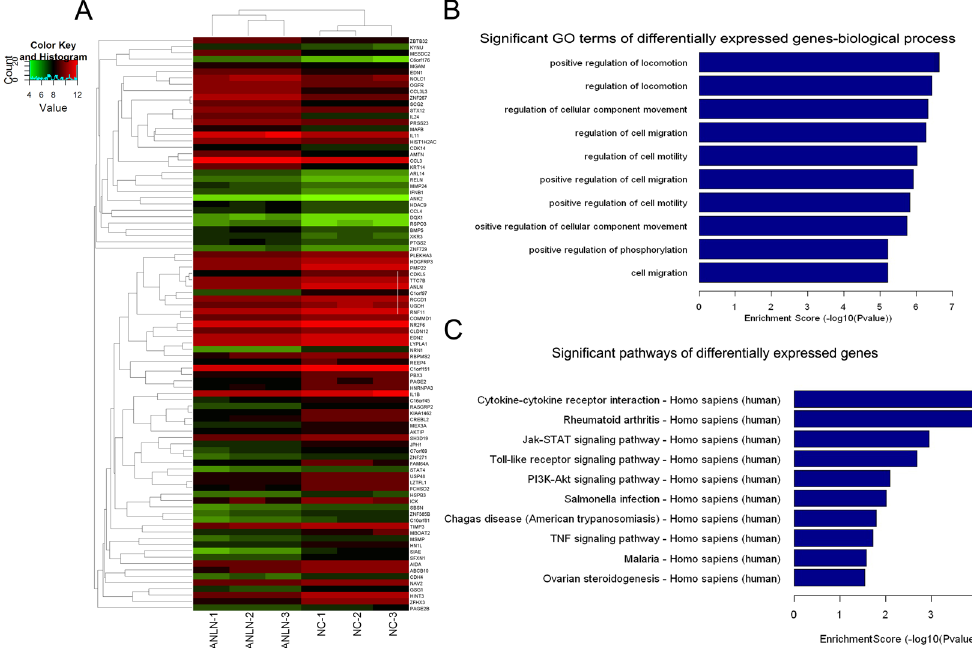
Figure 6. Changes of the gene expression profiling after knockdown of ANLN in J82 cells. ( A ) Hierarchical clustering heat map of the significantly dysregulated genes in 3 paired samples. ( B ) The top ten most obvious changes in GO biological process classification confirmed that ANLN was closely correlated with cell migration and locomotion. ( C ) Top ten enriched pathways for significant dysregulated